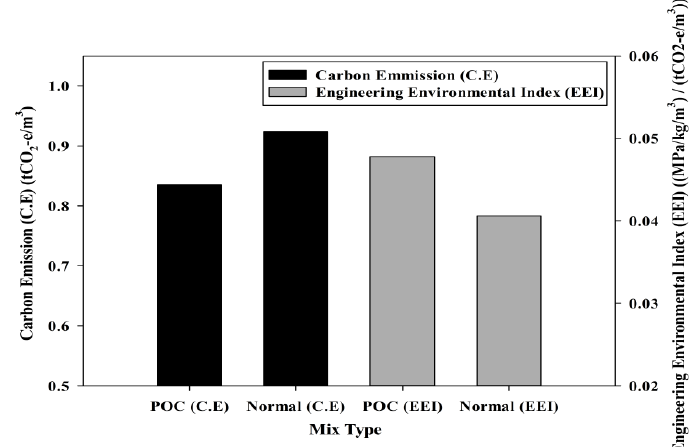
Figure 19. Relationship between carbon emission, mix type and engineering environmental index (Mineral Products Association [47], Department of Energy and Climate Change (DECC) [48]).